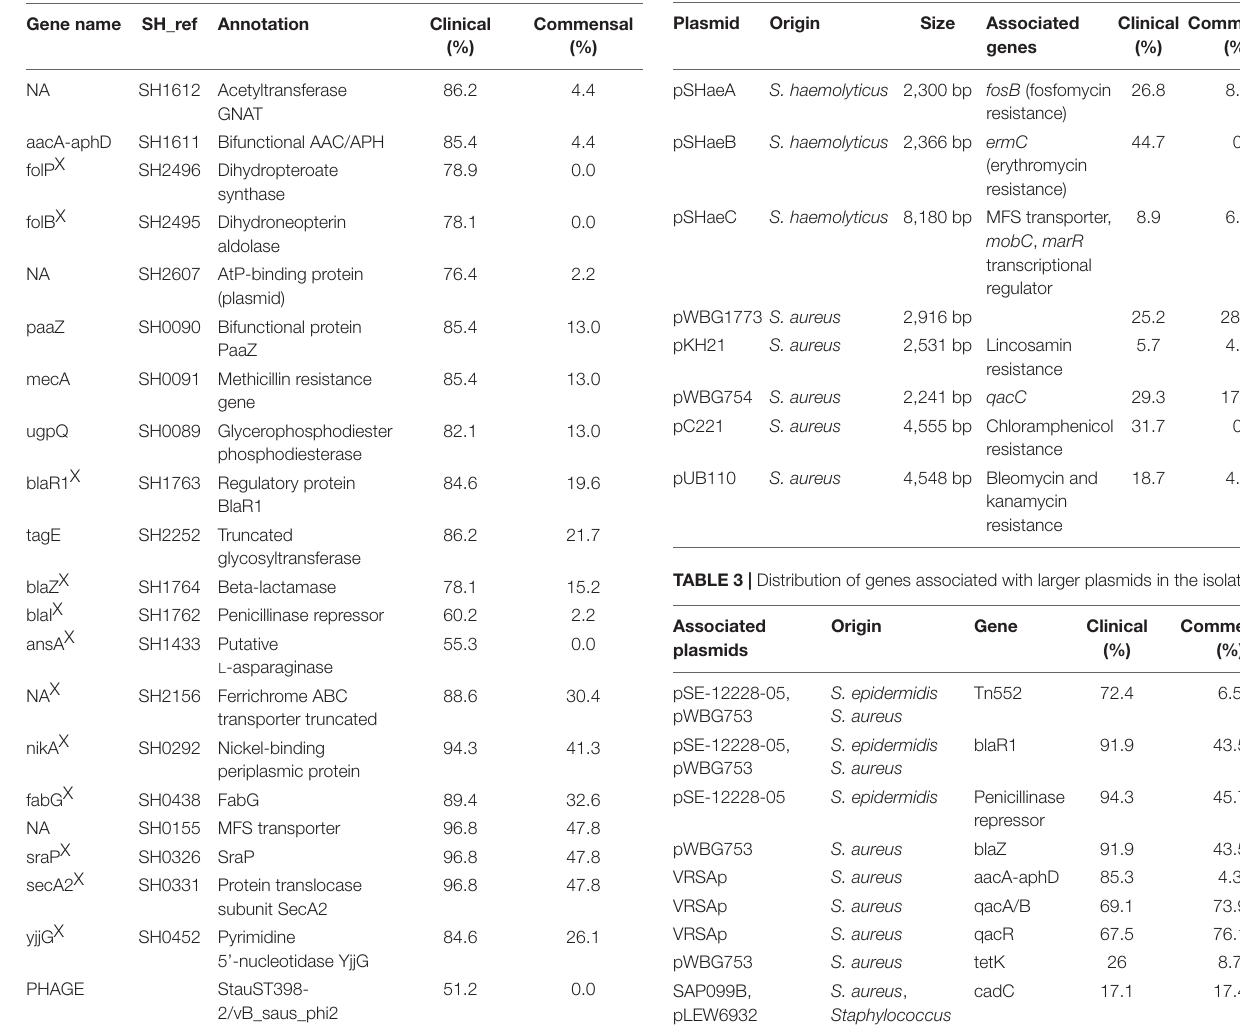
TABLE 1 | Genes and gene versions enriched in 123 clinical isolates, sorted by significance.